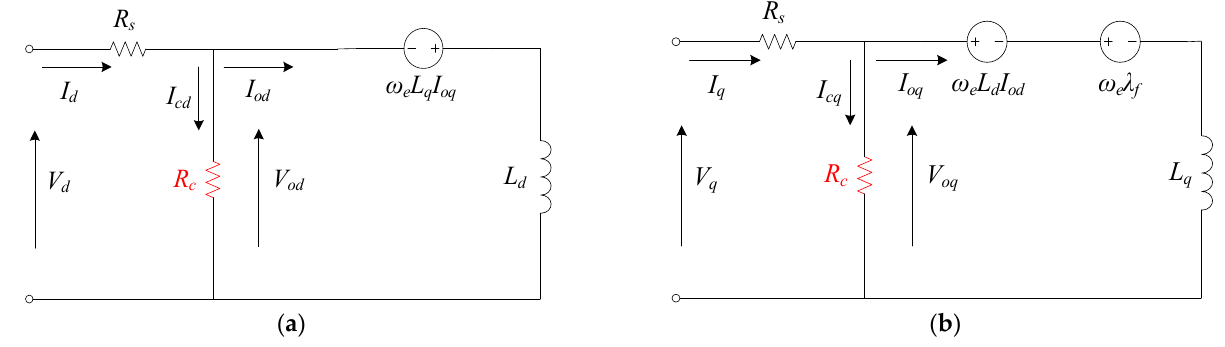
Figure 8. Per-phase ECM with predictable core loss of PMSMs [12].